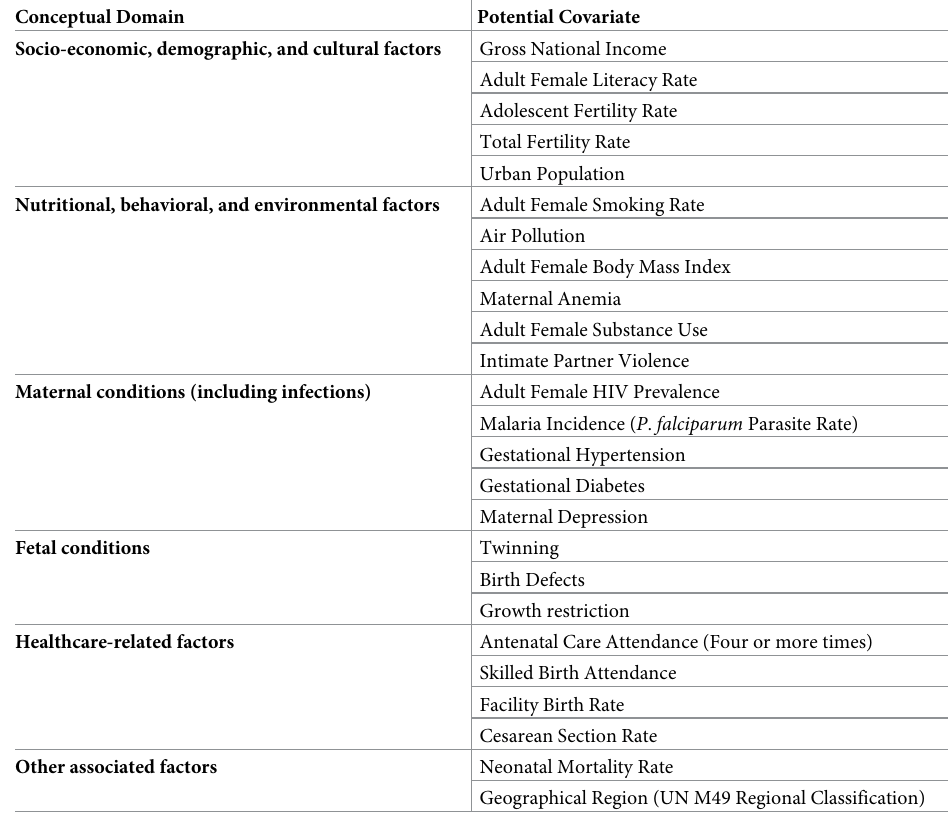
Table 2. Covariates for potential inclusion in the modelling analyses.